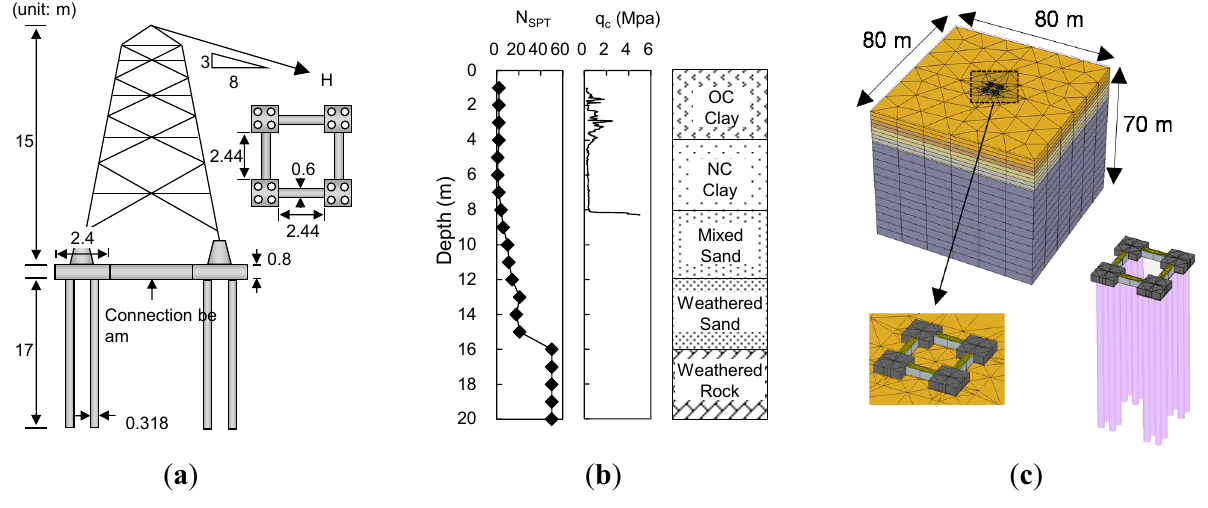
Figure 8. The prototype model test for connected foundation: ( a ) detailed configuration of prototype model; ( b ) site investigation results for the site; and ( c ) FE model configuration.